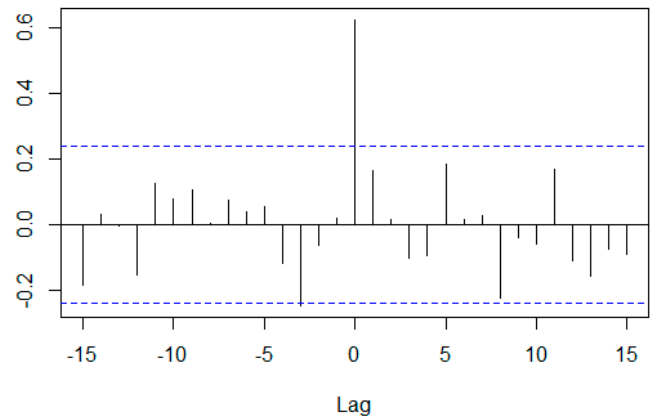
Figure 27. Cross-correlation coefficient between monthly rate of return of the whole sample group and monthly rate of return of the camera group for Jan 2013–Jul 2018.